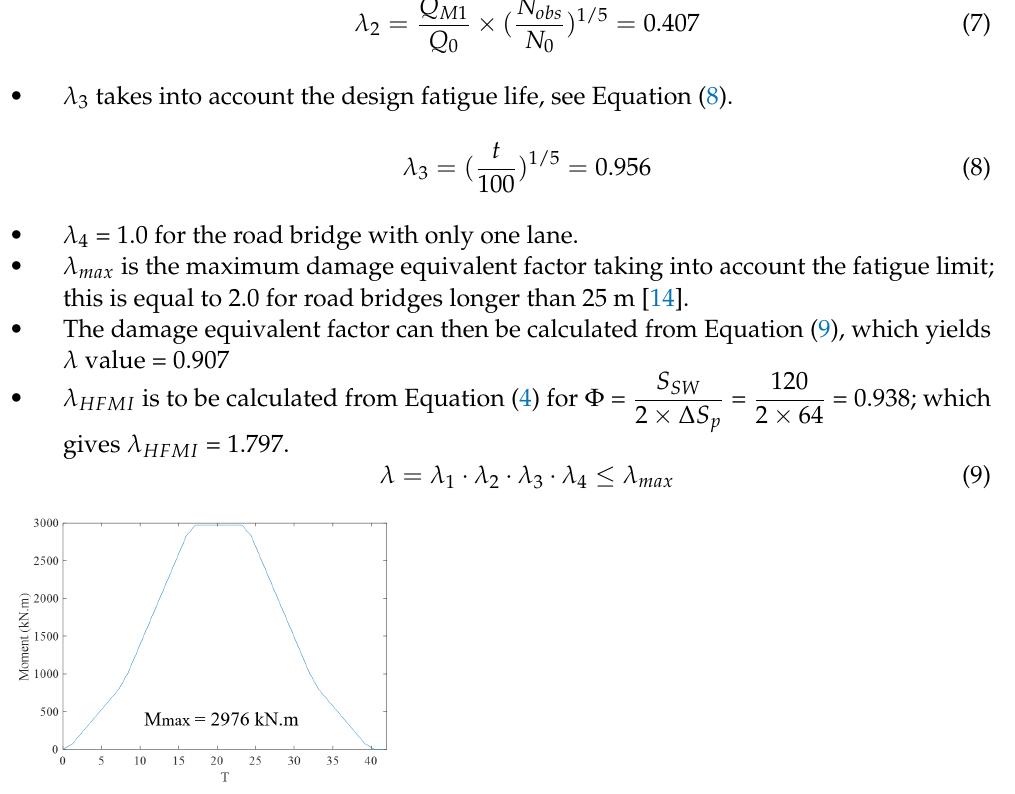
Figure 22. Moment response at bridge mid-span to